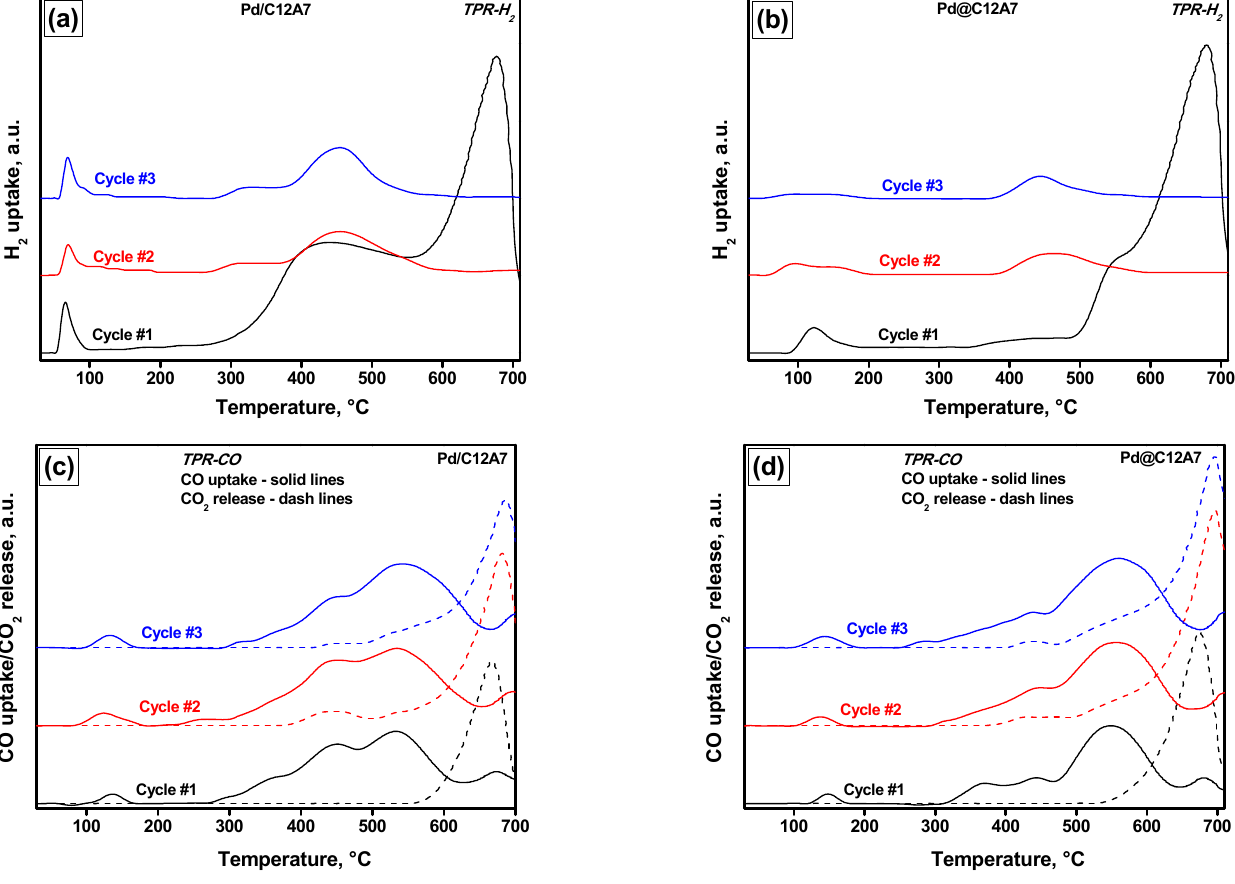
Figure 5. TPR-H 2 ( a , b ) and TPR-CO ( c , d ) profiles for the Pd-containing samples: Pd/C12A7 ( a , c );